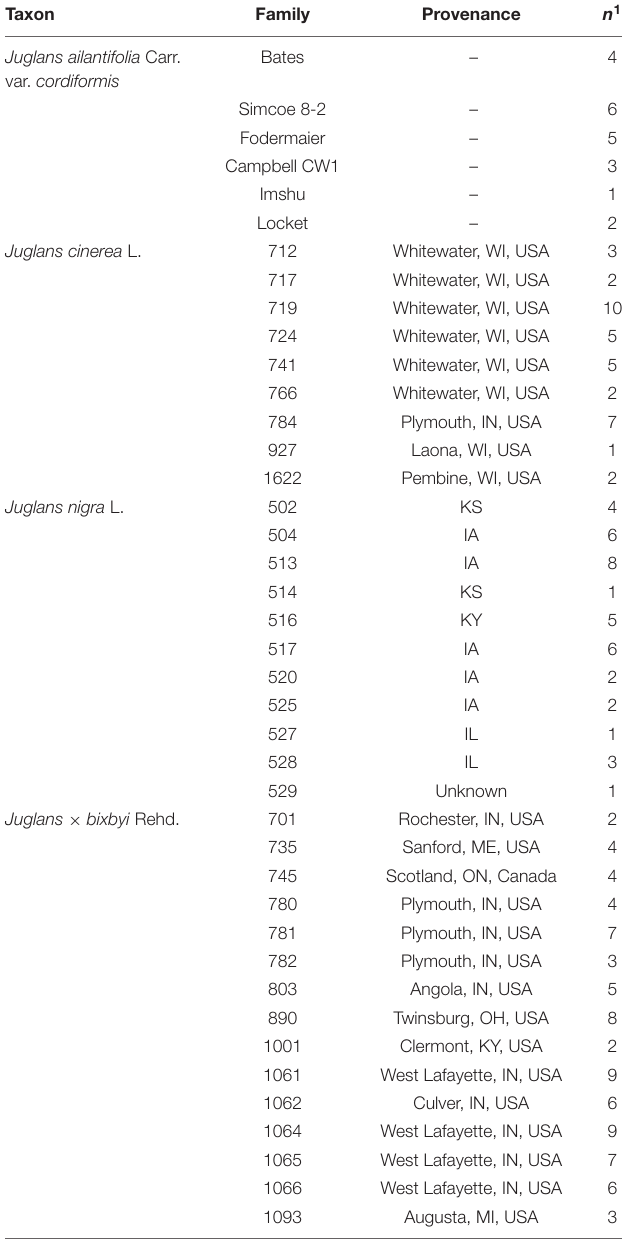
TABLE 2 | Family, provenance, and number of sample replicates for the four taxa included in the experiment: Juglans ailantifolia Carr. var. cordiformis (family = 6: total n = 21), J. cinerea L. (8: 37), J. nigra L. (11: 39), and J. × bixbyi Rehd. (16: 79). Taxon Family